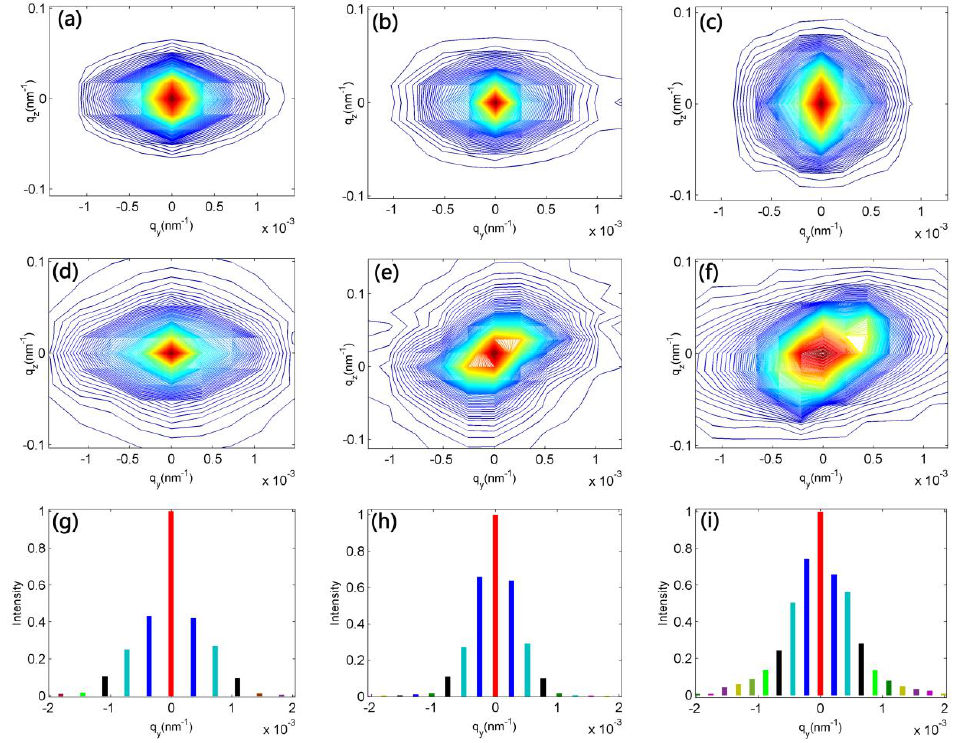
Figure 3. RSM of pristine and as-implanted MgO samples: ( a , d ) (110) orientation; ( b , e ) (100) orientation; ( c , f ): (111) orientation; ( g – i ): diffuse scattering distribution of implanted (110), (100), and (111) samples, respectively.